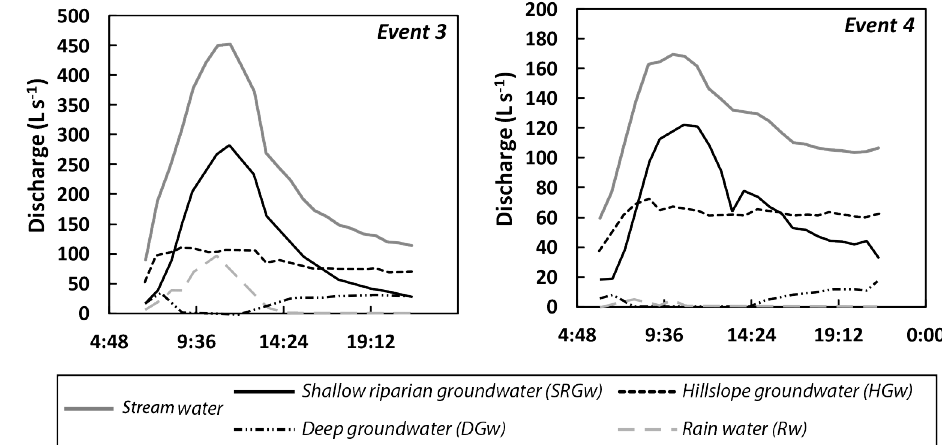
Figure 7. Examples of end-member mixing analysis used to determine the contributing waters during storm events no. 3 and no. 4.